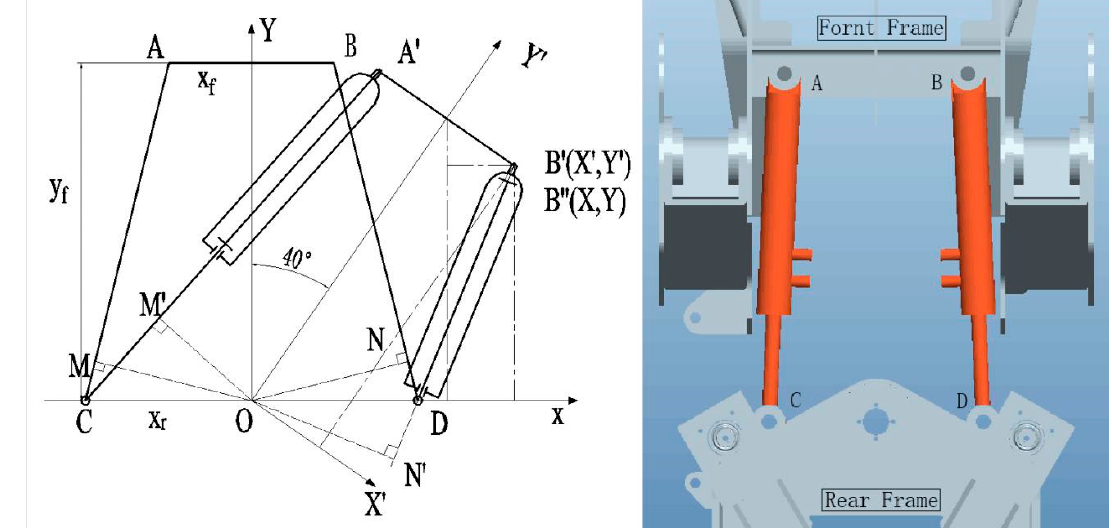
Figure 1. Schematic diagram of the steering mechanism.